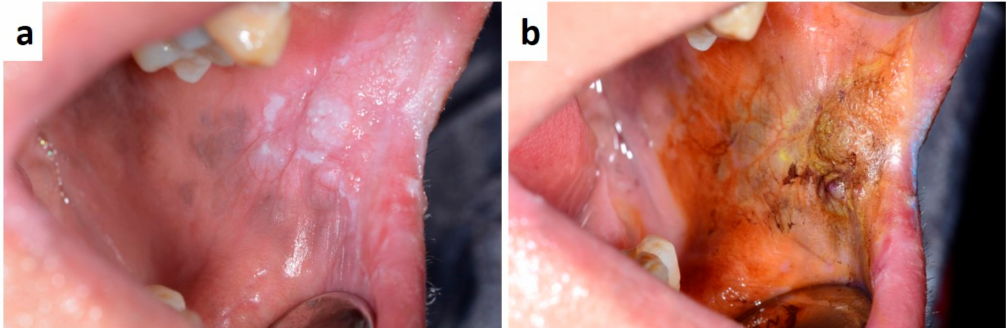
Figure 11. Non-homogenous hyperkeratotic patches with partial ulceration of the cheek and labial commissure following allogenic hematopoietic stem cell transplantation ( a ); a careful clinical examination with the use of vital dies (toluidine blu and Lugol’s solution), ( b ) highlighted area of potential malignant transformation, subsequently diagnosed as epithelia dysplasia and early squamous cell